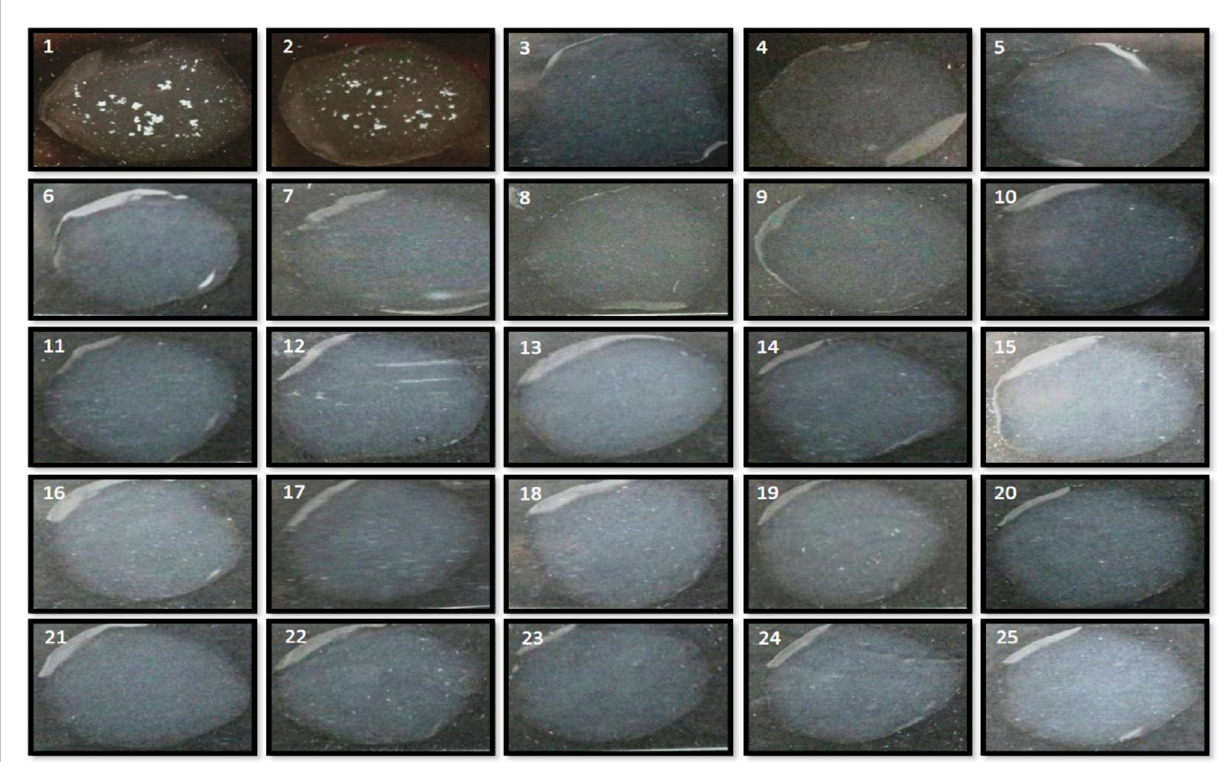
FIGURE 12 Estimationforinvestigationoftestspeci fi cityofdirect-differentialslideagglutinationassaywithWCantigenof Brucella andothercloselyrelatedand non-related bacterial species to evaluate the cross-reactivity at an obtained experimental LOD of 10 4 CFU mL − 1 . No clumping for positive agglutination reaction was observed, and the results were inferred as “ Test Negative ” for the developed assay on testing along with positive test controls ( Brucella abortus S99 and Brucella melitensis 16M) of Brucella